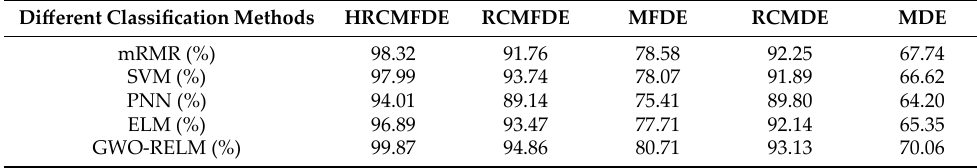
Table 5. Comparison of models under different classification